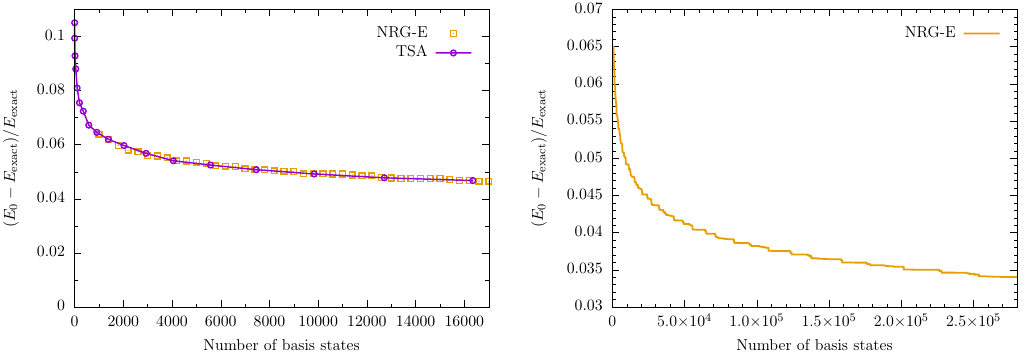
Figure 2: Convergence of the approximate ground state energy E with the num- 0 ber of basis states, as computed using the truncated spectrum procedure (TSA) and = 20 ground state its numerical renormalization group extension (NRG-E). The c i = 10 eigenstates for 10 parti- of the Hamiltonian (1) is constructed in terms of c f = 600 and ∆ N = 200 (corresponding to an initial cles. NRG-E is performed with N s s energy cutoff of Λ ≈ 50). We plot every other NRG-E step; excellent agreement between the results of the numerical renormalization group and the truncated spec- trum approach is seen (left panel). The numerical renormalization group procedure can access number of basis states far beyond those accessible to full diagonalization (right